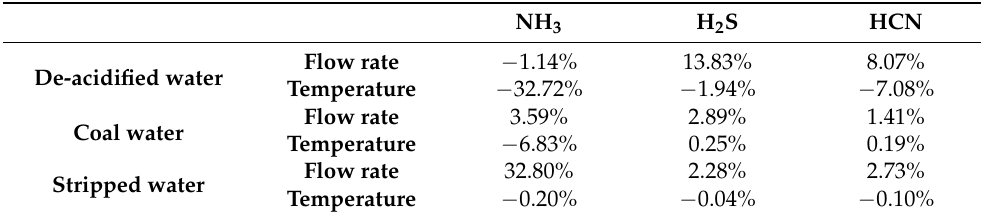
Table 5. Results of sensitivity analyses.